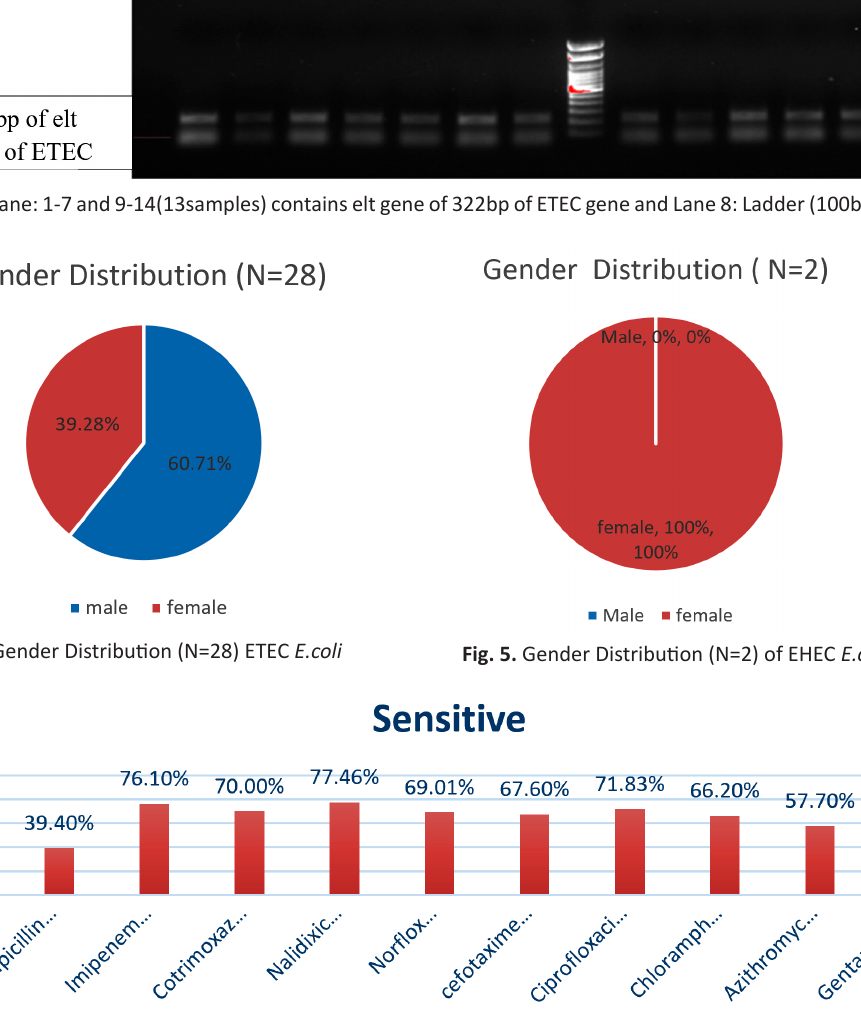
Fig. 6. Antibiotic sensitivity data of 71 E .coli